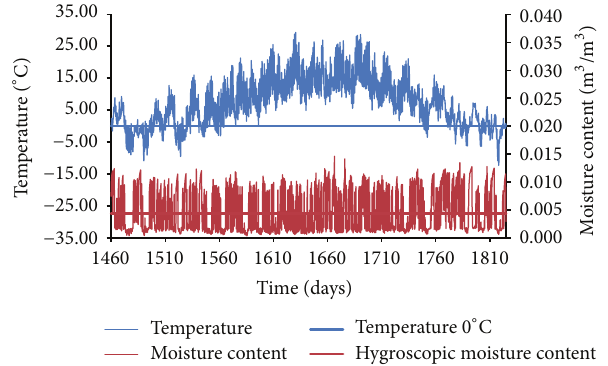
Figure14:Temperatureandmoisturecontentversustimefunctions, SL sandstone, ˇSer´ak.